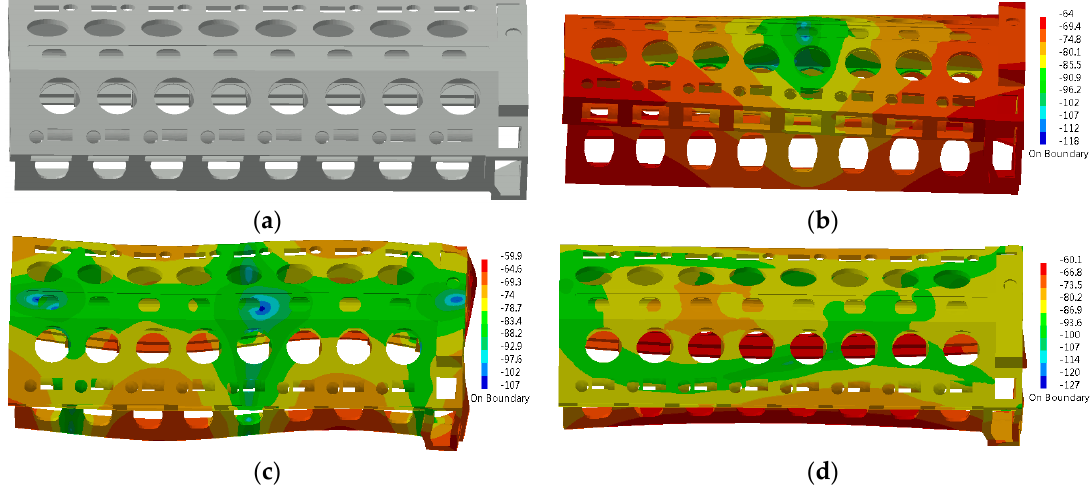
Figure 6. Modal shapes of the engine block. ( a ) Original model; ( b ) First-order mode; ( c ) Fifth-order mode; ( d ) Tenth-order mode.